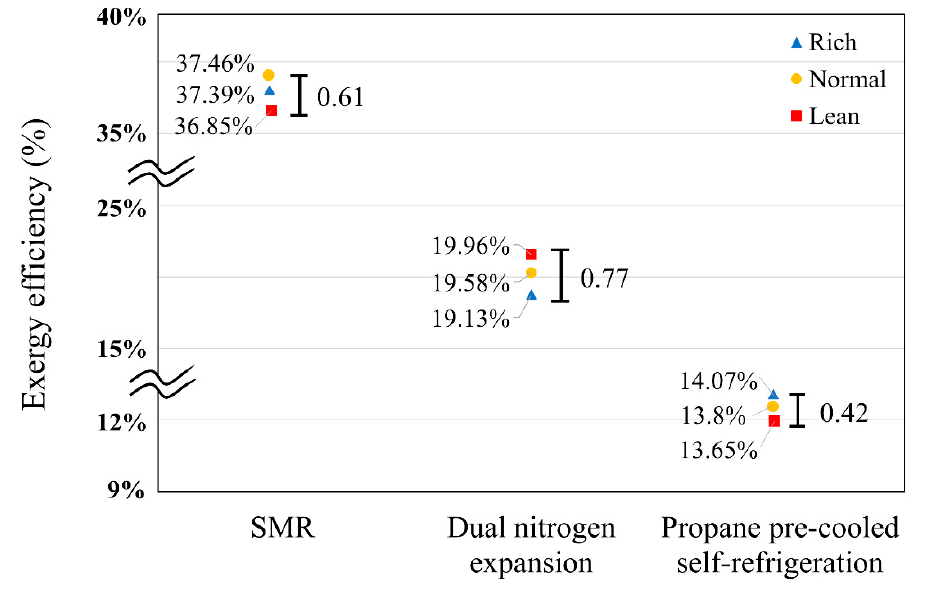
Figure 10. E ff ect of natural gas compositions on each Figure 10. Effect of natural gas compositions on each process. Figure 10. Effect of natural gas compositions on each process.